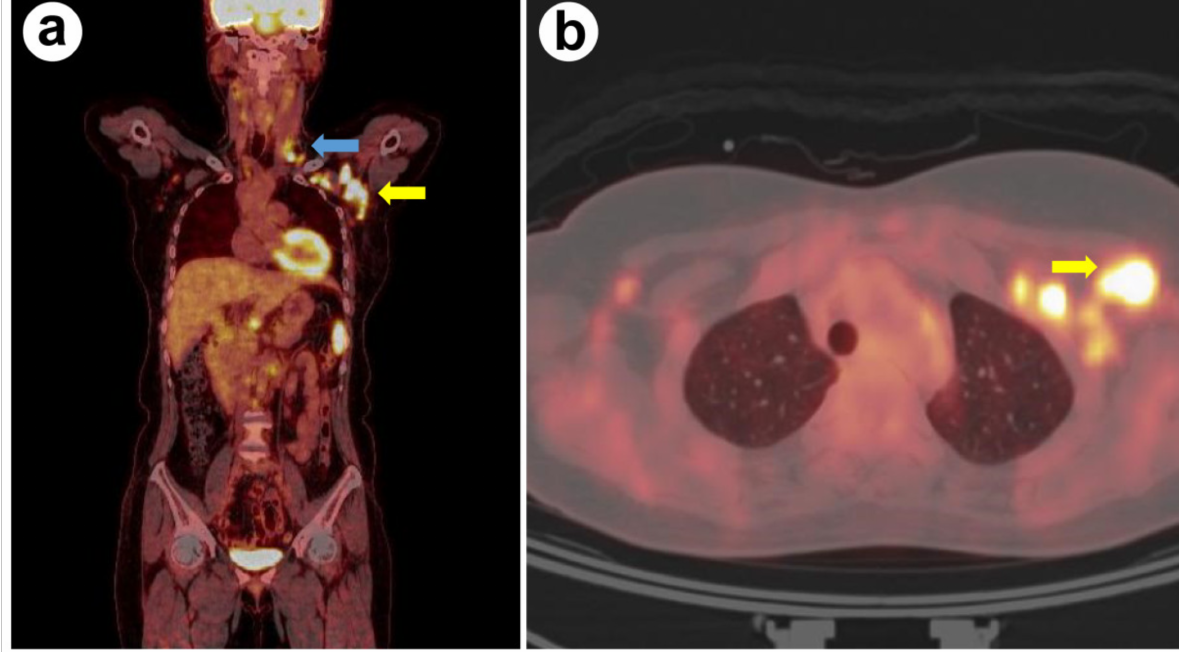
Figure 2. ( a ) 18 F-FDG PET/CT findings of the patient, coronal view; blue arrow points to supraclavicular lymph node, yellow arrow points to the axillary lymph node. ( b ) 18 F-FDG PET/CT findings of the patient, horizontal view; yellow arrow points to the axillary lymph